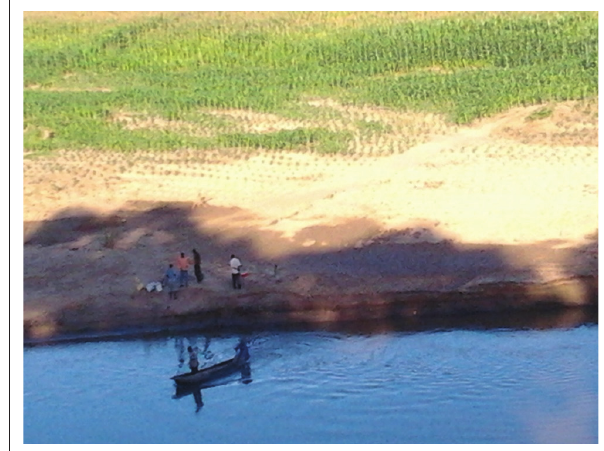
FIGURE 3: Maize crops grown along the Hunyani